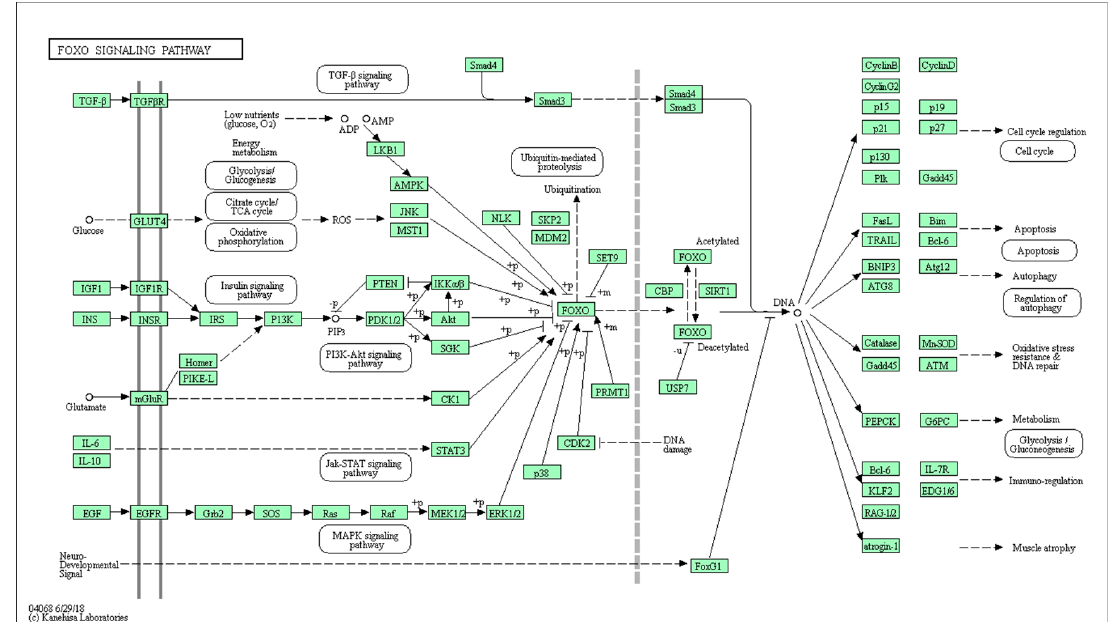
Figure 3. FOXO signaling pathway.